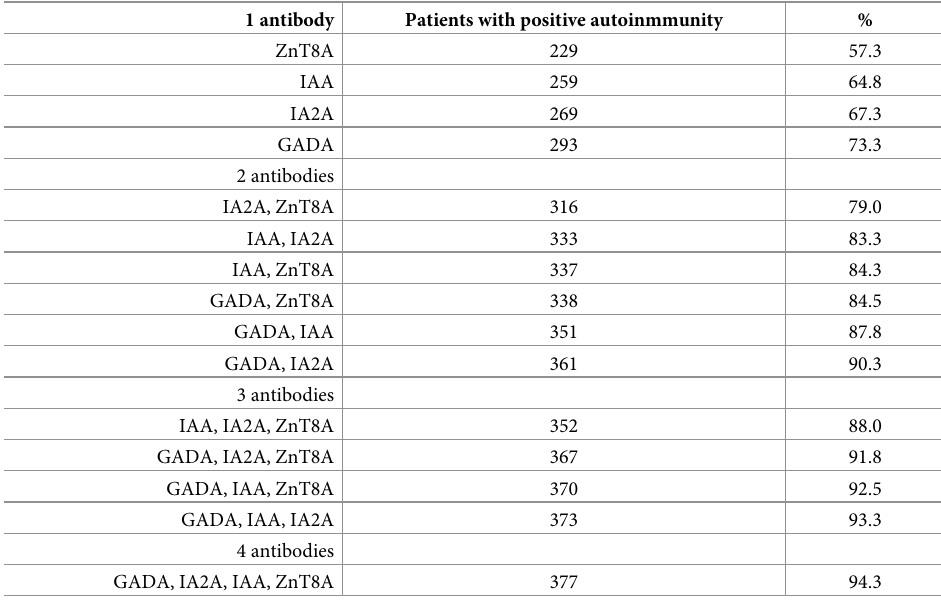
Table 3. Patients with positive autoimmunity according to the number of antibodies evaluated. 1